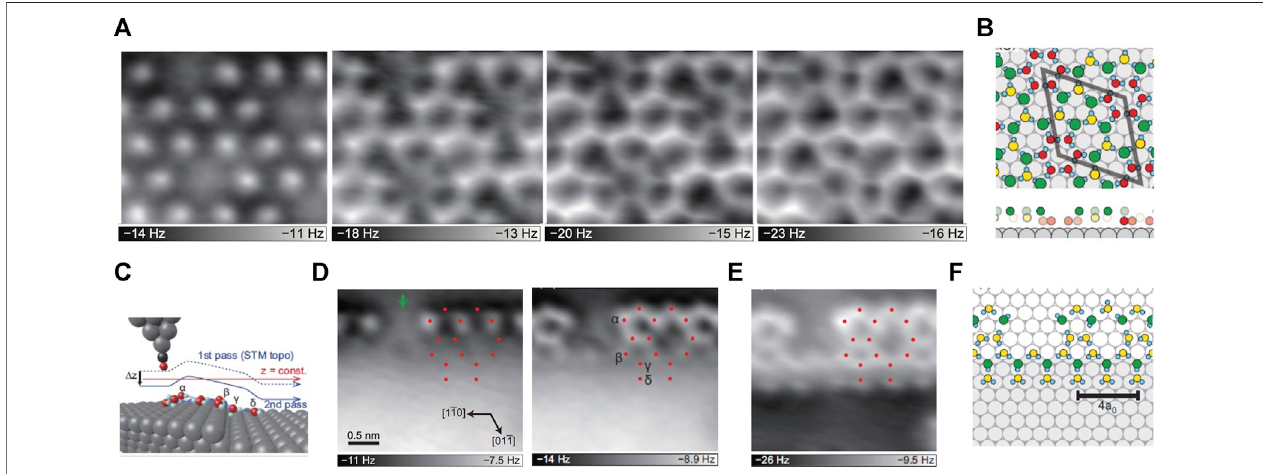
FIGURE1| 2Dwaternetworks onNi(111) (A) AFMimagesofthe2Dwaternetworksofthesame areaontheterraces,thetipheightdecreases fromlefttoright (B) The proposed structure of the water monolayer based on the AFM images. The gray, cyan, green, yellow and red spheres represent Ni, H, topmost O, middle O and bottommost O atoms, respectively; the unit cell of ( √ 28 × √ 28) R19 is represented by the gray rhombus; the bottom panels are the side-view of the above structures, without H atoms for clarity (C) The schematic diagram of the tip and step. The gray, cyan, black and red spheres represent Ni, H, C and O atoms, respectively (D) Constant-height AFM images of the water network at the step edge, the tip height decreases from left to right (E) AFM image of the same region in (D), but the tip trajectoryisconsistentwiththatoftheSTMimage,asthesolidbluelinein( C) .Thereddotsin (D – E) representtheO-atompositions (F) Thewaternetworkstructureatthe step edge proposed based on the AFM images. Adapted with permission from Shiotari, et al., 2019. Physical Review Materials 3(9): 093,001 (Shiotari et al.,